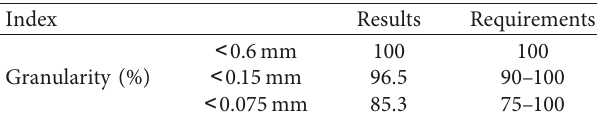
Table 2: Base properties of mineral powder.